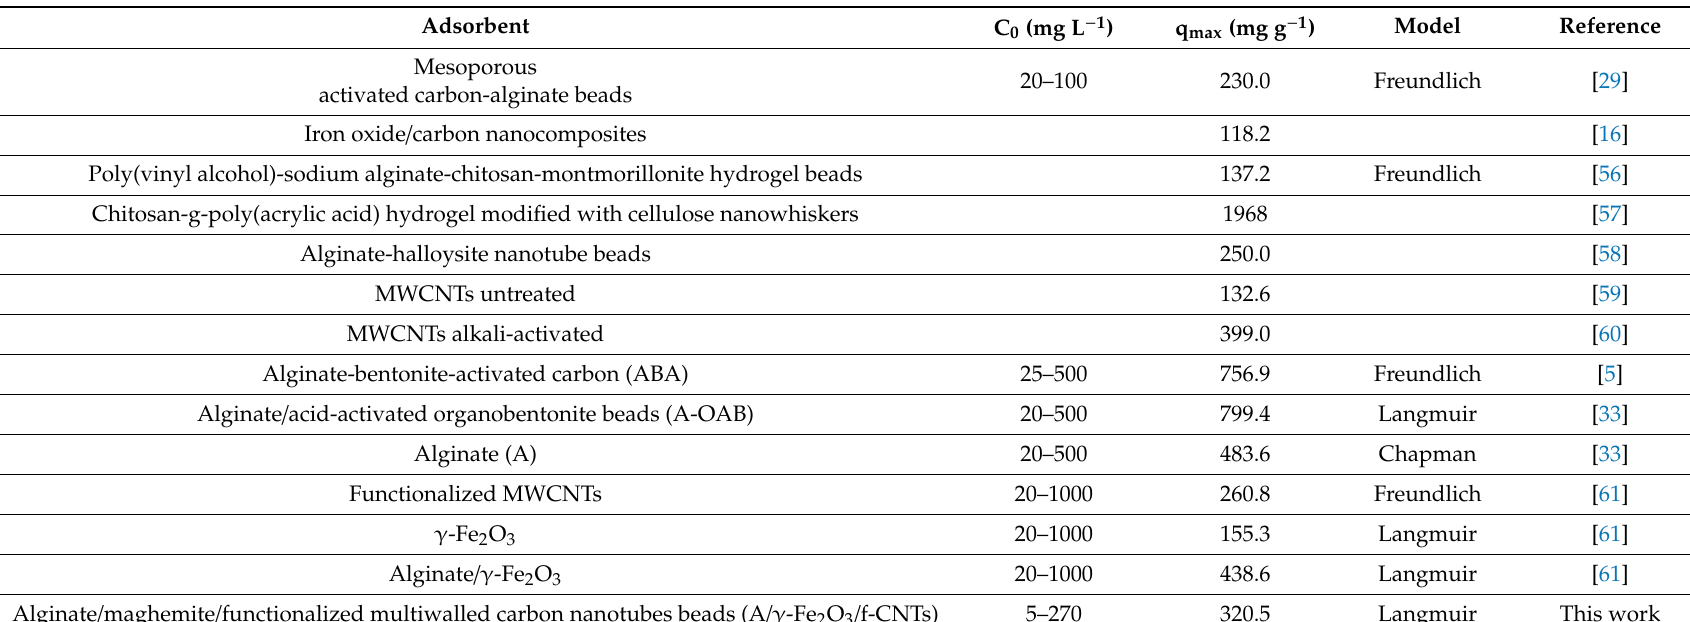
Table 3. Comparison of several MB adsorption capacities reported in the